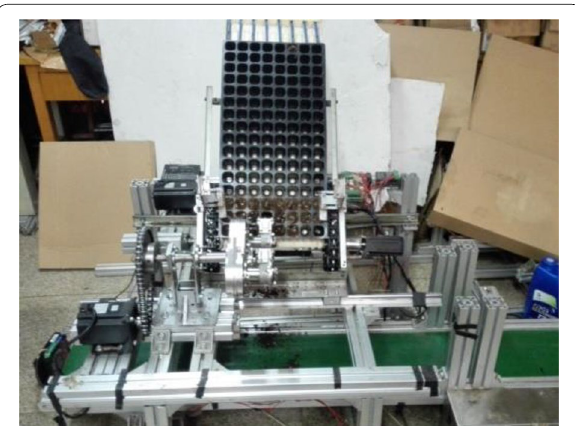
Figure 13 Test bench for the seedling pick-up